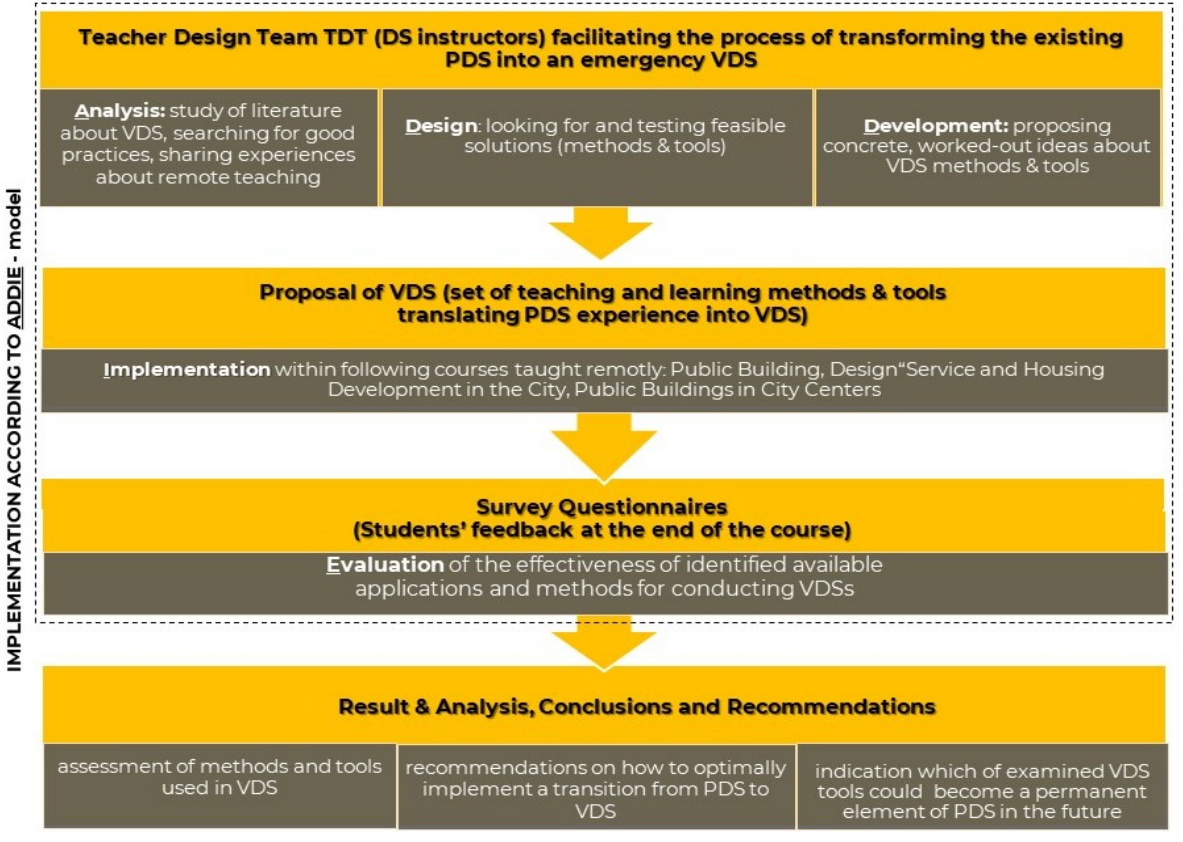
Figure 1. The structure of the redesign process of transforming the existing PDS into an emergency VDS, implemented according to ADDIE-model.